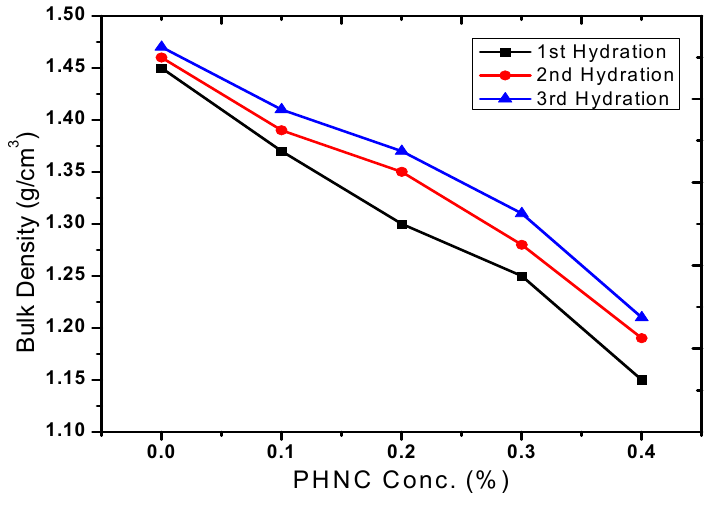
Figure 9. Effect of PHNC on soil